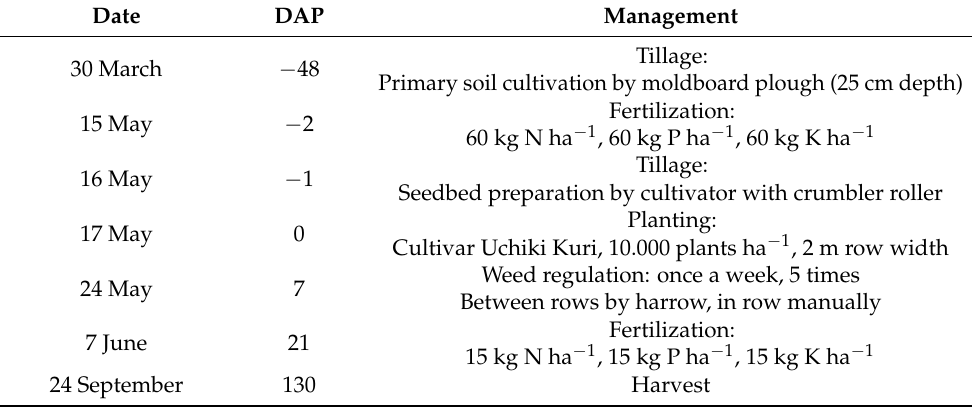
Table 1. Agronomic management during the cropping season 2017. DAP: days after